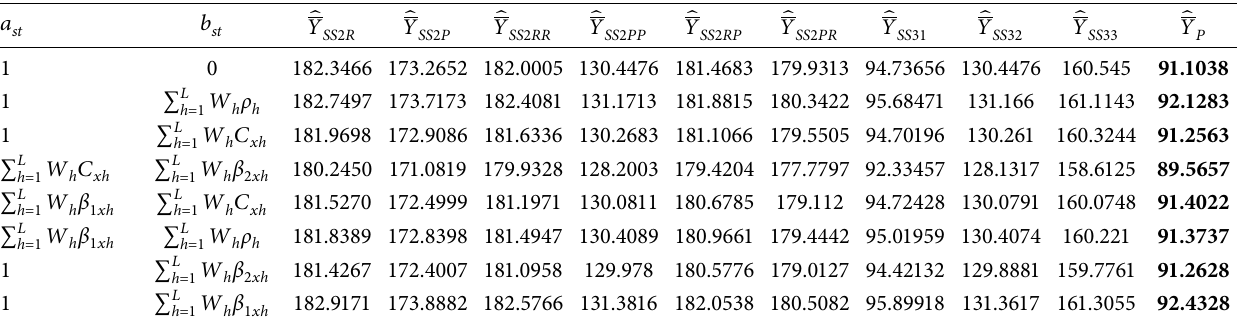
Table 7: Minimum MSEs of different estimators based on the simulation study ( n �